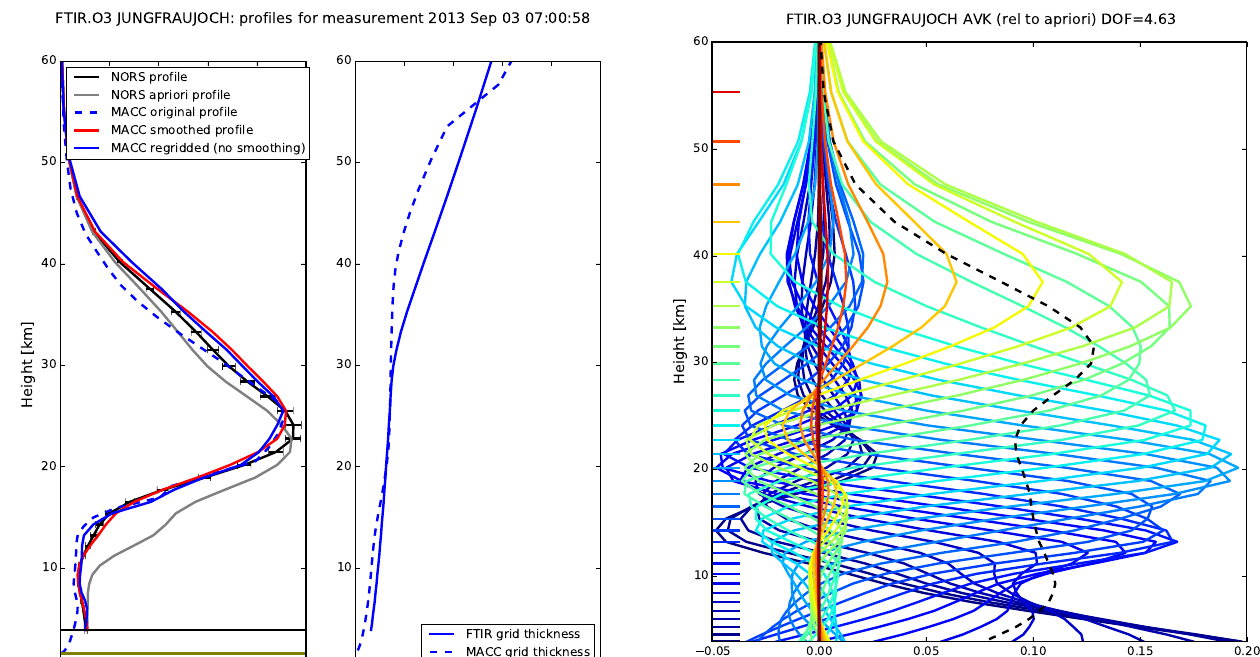
Figure 5. Example of a O 3 FTIR measurement averaging kernel. The plot shows the rows of the AVK matrix, color coded according to the height that corresponds to each row. The matrix elements of an AVK are without unit (the depicted AVK acts on O 3 profiles rel- ative to the a priori profile). The black dashed line is the sensitivity (the sum of each row): for rows with zero sensitivity the smoothing formula returns the a